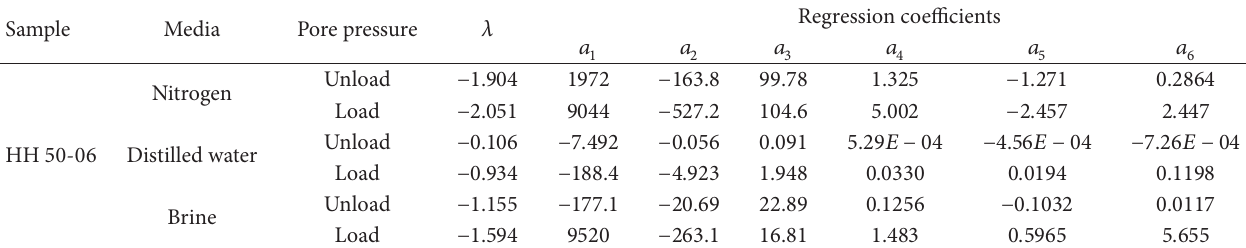
Table 2: Conversion factors and regression coefficients measuring by nitrogen, distilled water, and brine.